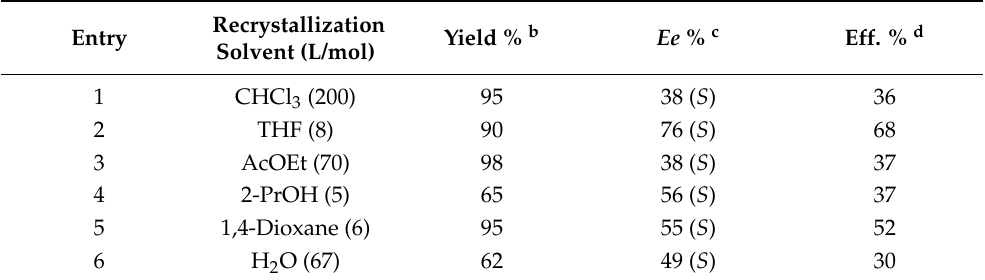
Table 2. Optical resolution of racemic 3-hydroxy-4-(4-chlorophenyl)butanoic acid ( rac - 2 ) with (+)-ADPE a